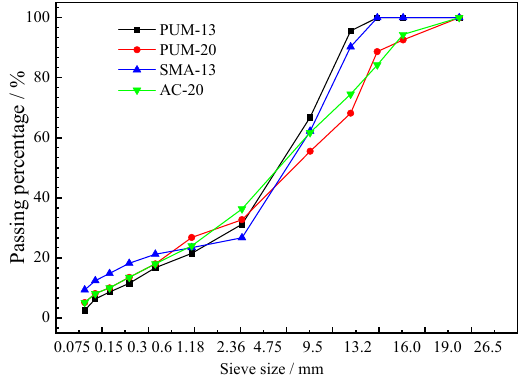
Figure 2. Mineral aggregate gradation design results.